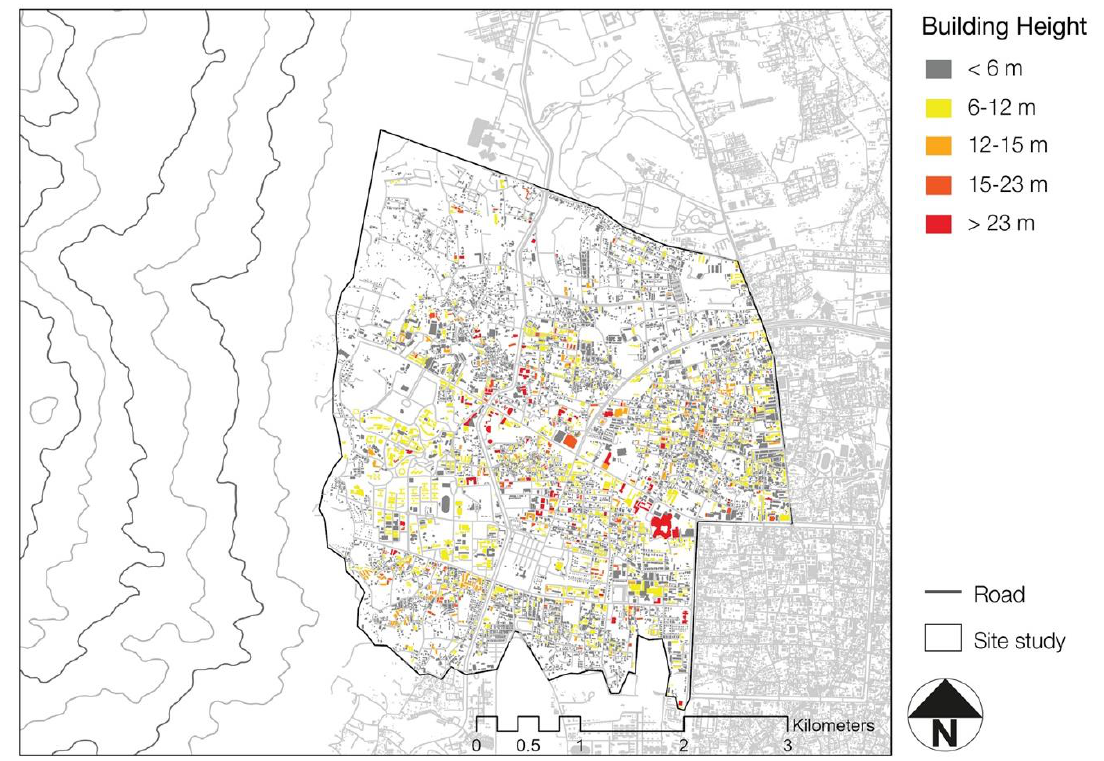
Figure 2. Existing building heights in the study area (Source: Authors).